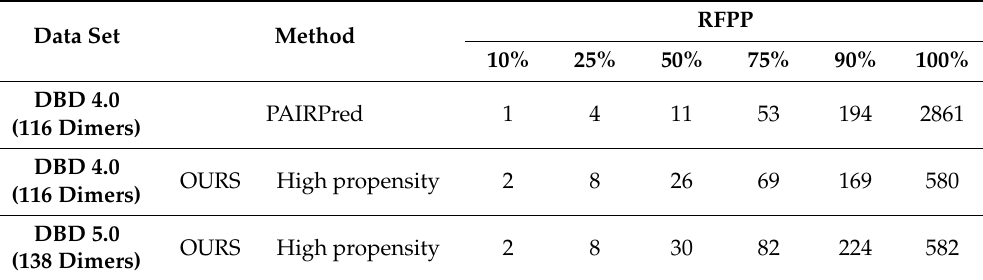
Table 4. Comparison of RFPP with PAIRP (red).